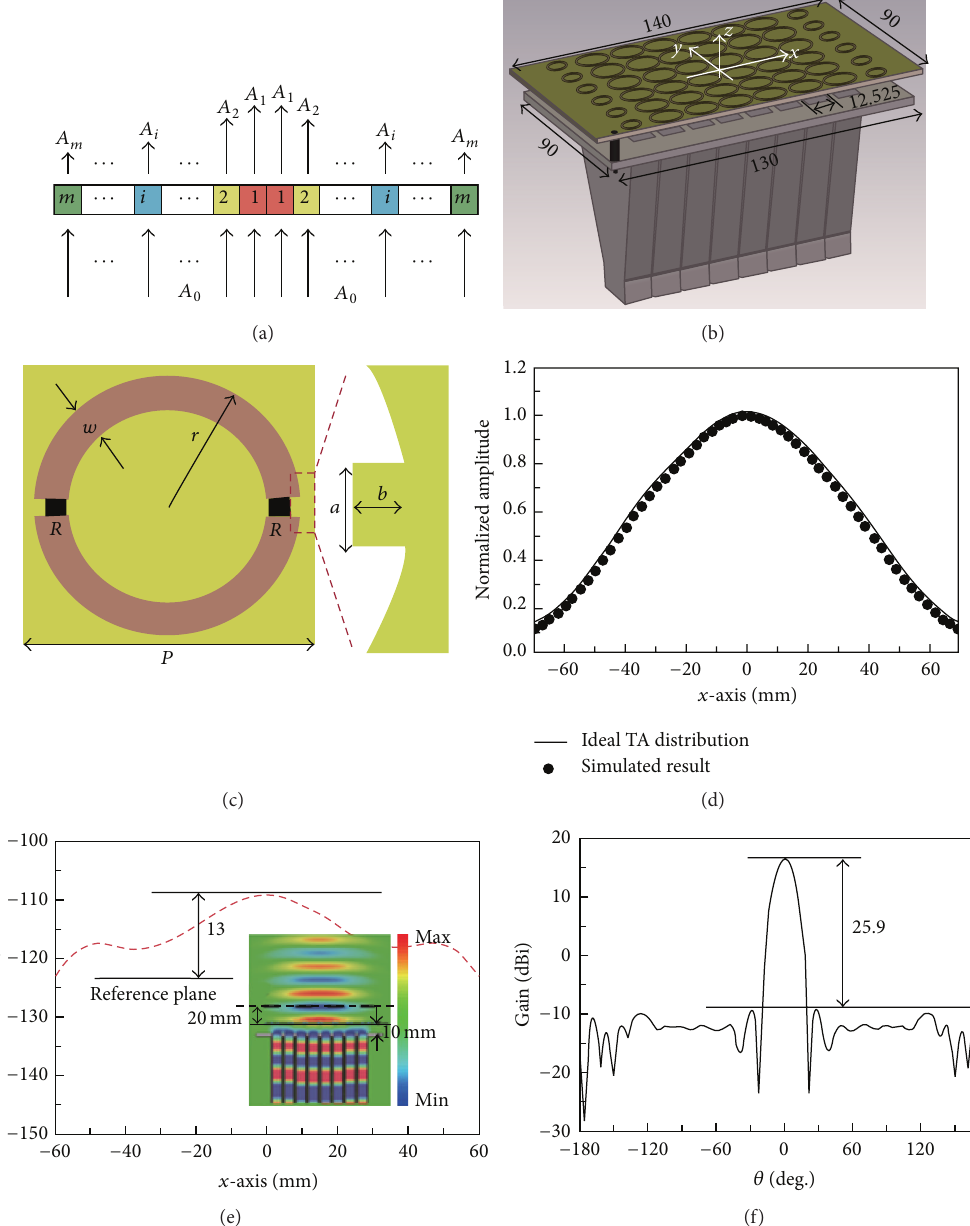
Figure 43: (a) Principle of the sidelobe reduction with the metasurface superstrate. (b) The geometry of the amplitude tunable metasurface to reducethesidelobeofthehornantennaarray.(c)Schematicoftheunitcellofthemetasurface.(d)Comparisonofthenormalizedtransmission amplitude distribution of the proposed antenna composite and the ideal Taylor amplitude distribution. (e) Phase distributions at the reference plane. The inset figure shows the electric field distribution at 𝑥𝑧 -plane. (f) Radiation pattern in the 𝐸 -plane of the antenna composite at 10.3 GHz with sidelobe level of − 25.9